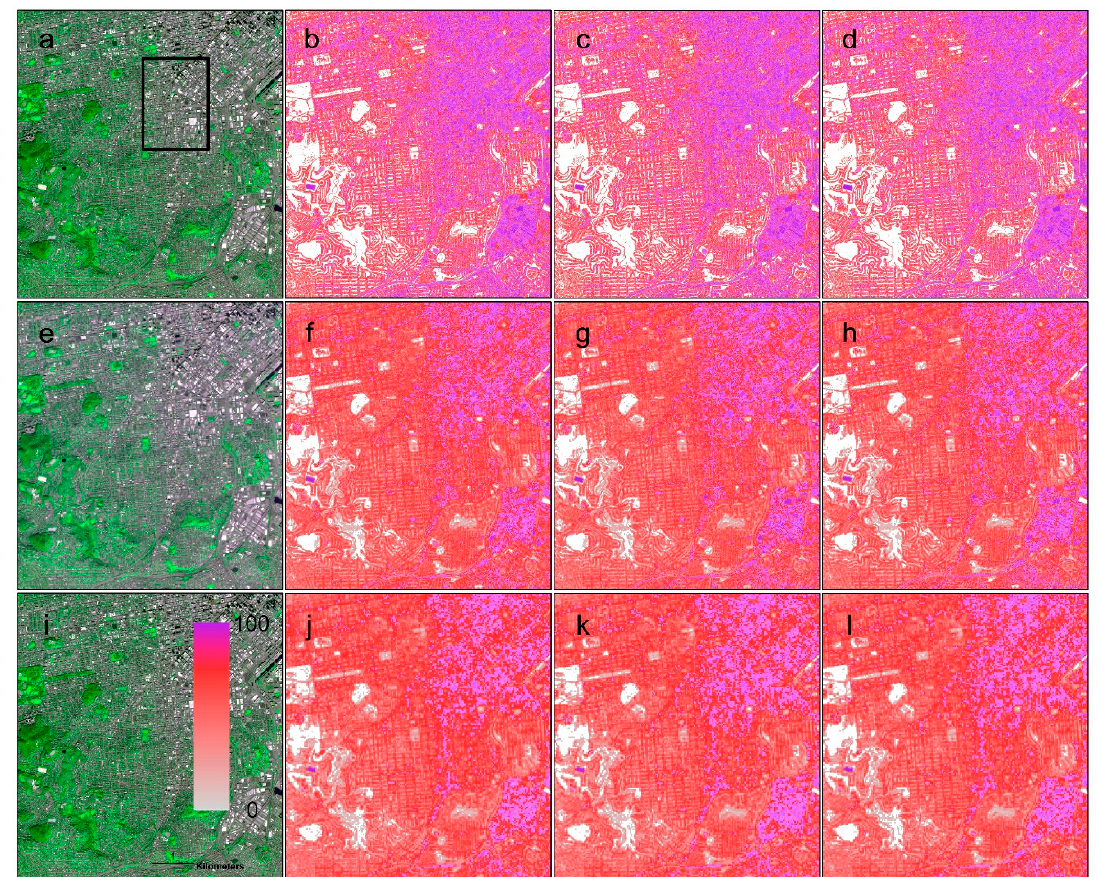
Figure 7. WV3 images ( a : 10 m, e : 20 m, i : 30 m; displayed using bands of R, NIR-1, G) and derived ISAs from images with half, three-quarters, and twice the Landsat OLI SNRs at 10-m ( b – d ), 20-m ( f – h ), 30-m ( j – l ) resolutions in San Francisco, California. The non-ISAs are in white.